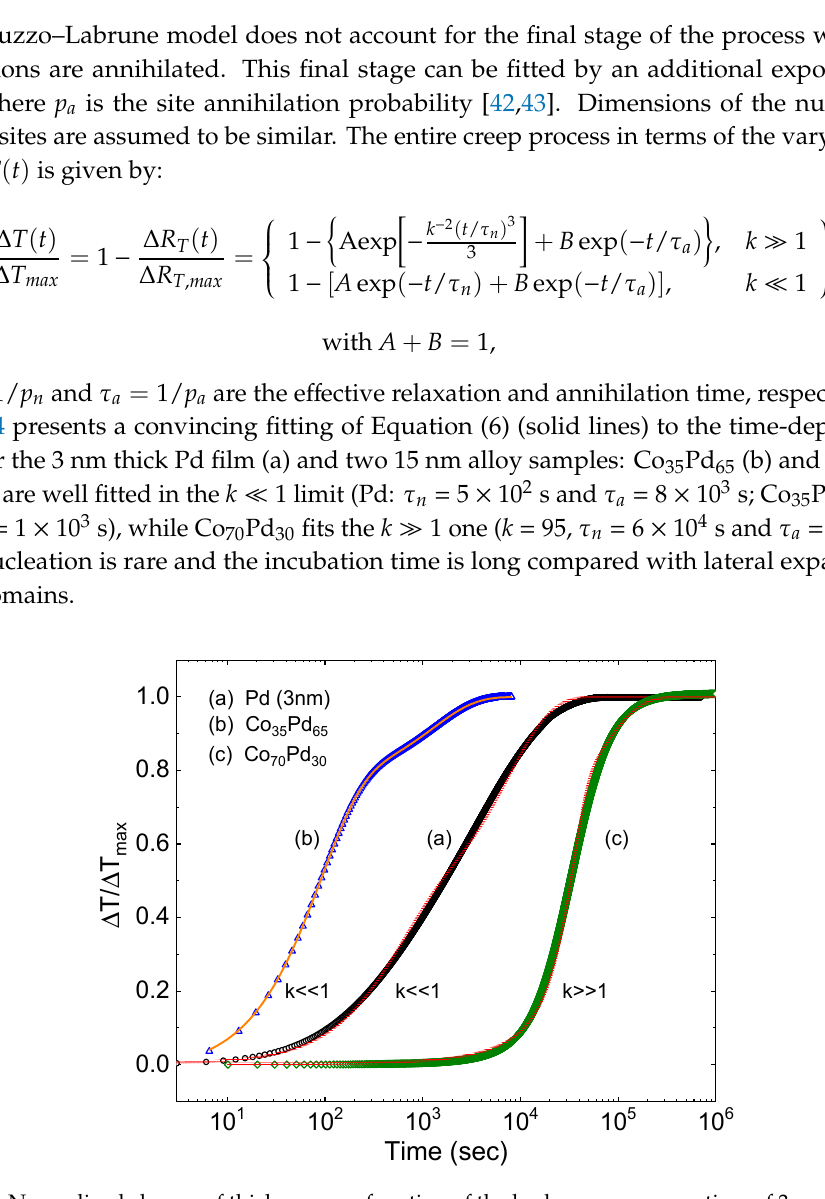
Figure 4. Normalized change of thickness as a function of the hydrogen exposure time of 3 nm thick Pd ( a ), 15 nm thick Co 35 Pd 65 ( b ) and 15 nm thick Co 70 Pd 30 ( c ) films. Symbols represent the experimental data and lines are fitted by Equation (3). Samples ( a ) and ( b ) were fitted in the 𝑘 ≪ 1 limit and sample ( c ) in the 𝑘 ≫ 1 one.